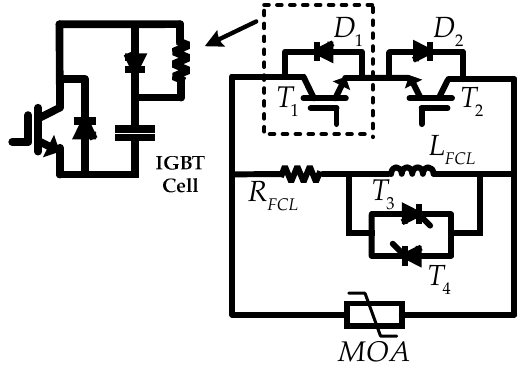
Figure 13. Proposed enhanced fault current limiting circuit.